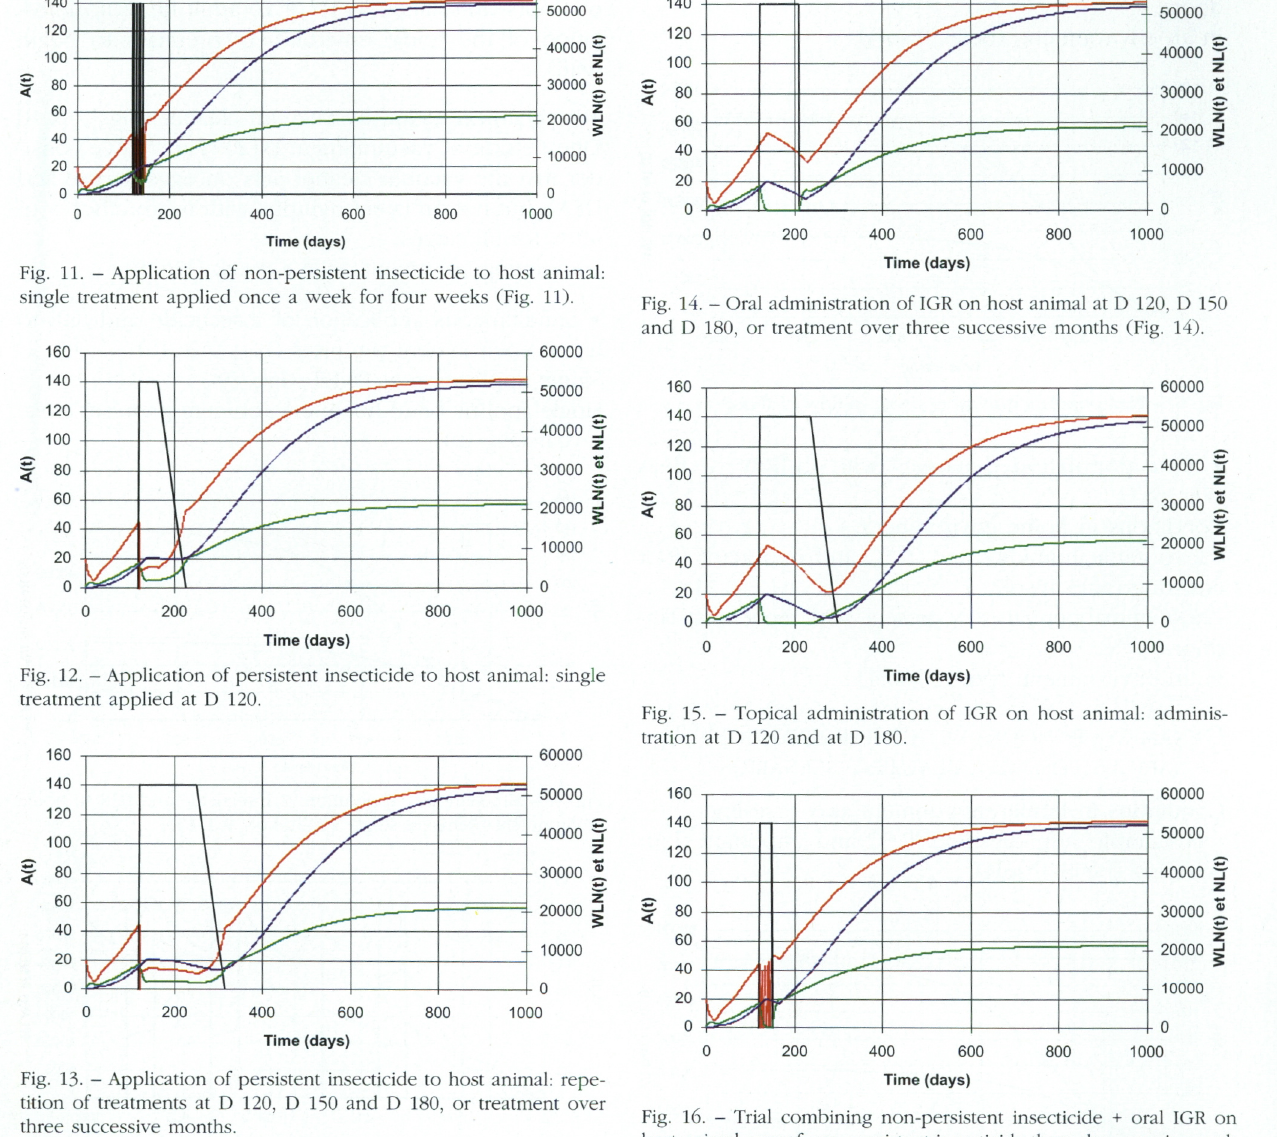
Fig. 13. - Application of persistent insecticide to host animal: repe­ tition of treatments at D 120, D 150 and D 180, or treatment over three successive months.